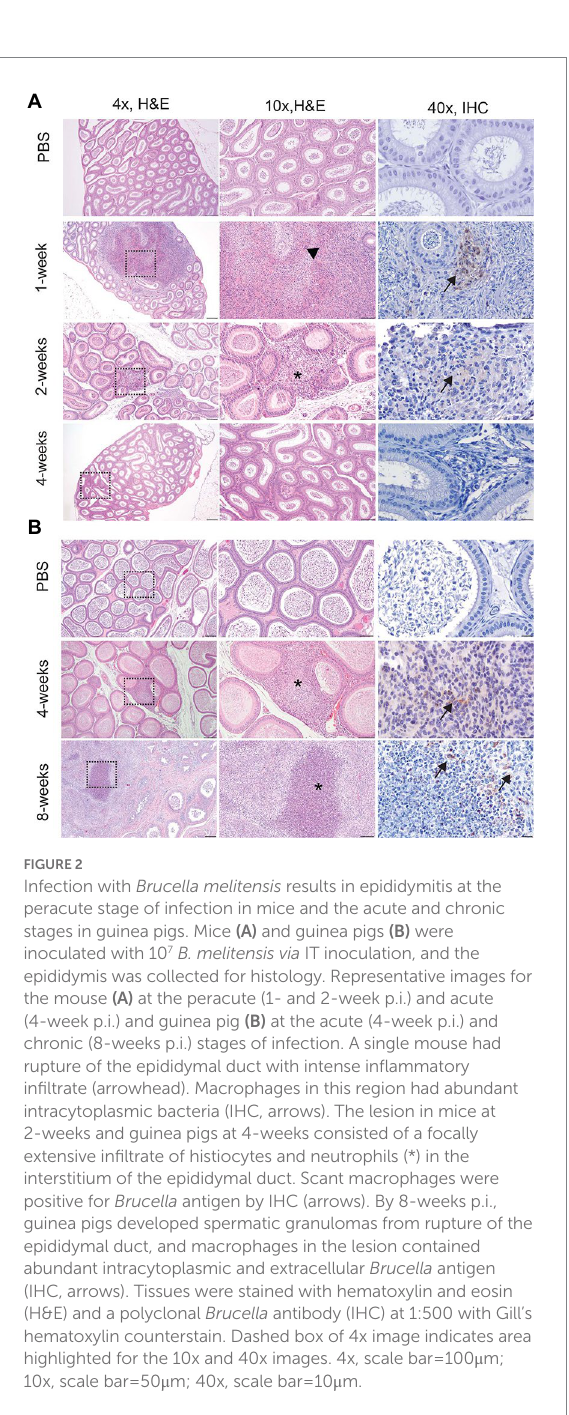
(Figure 3B). Similar to the mouse during the acute stage of infection, the histologic lesions at 4-weeks consisted of multifocal inflammatory infiltrates of macrophages and neutrophils in the interstitial tissue of the epididymal duct (Figure 2B). However, by 8-weeks p.i., colonization was 1.1 logs, but the mean histologic score was significantly increased ( p < 0.01) compared to 4-weeks p.i. and PBS controls ( p < 0.01; Figure 3B). At 8-weeks p.i., the epididymal changes consisted of multifocal to coalescing